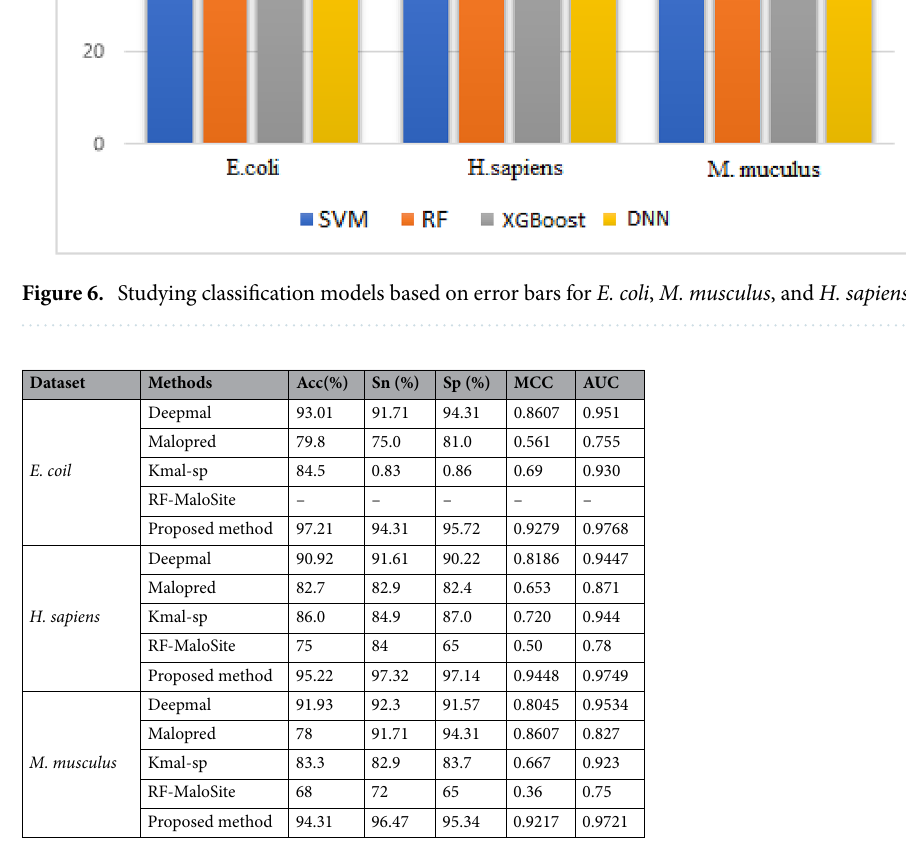
Table 5. A comparison between the proposed method and the approaches of DeepMal, Kmal-sp, Malopred, and